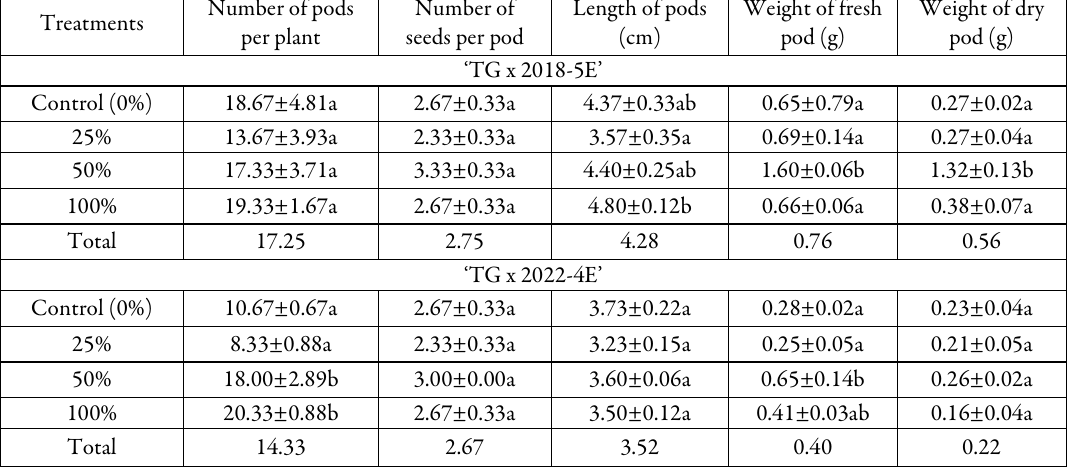
Table 3. Pearson’s correlations among some agro-morphological parameters for ‘TG x 2018-5E’ Plant height at